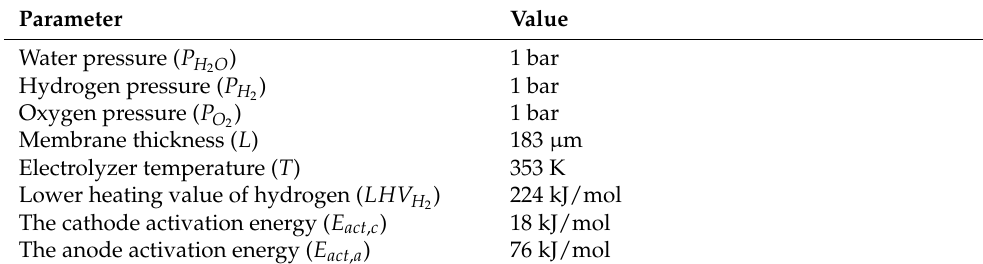
Table 2. Fixed parameters for modeling the polymer membrane electrolyzer